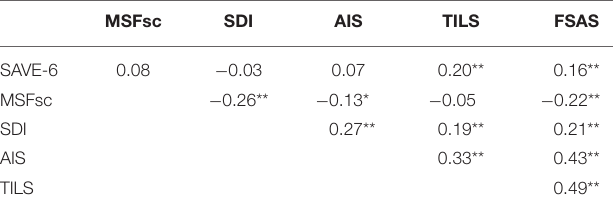
TABLE 2 | Correlation between the